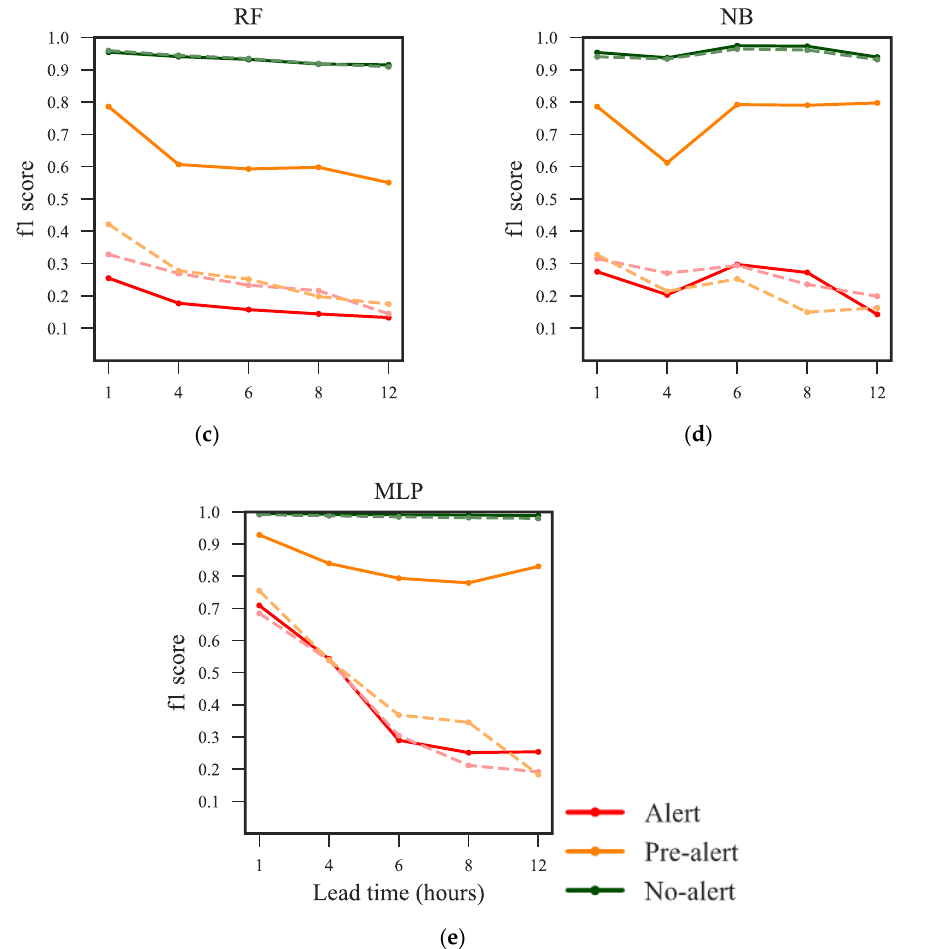
Figure 6. f1 scores per flood warning state ( No-alert , Pre-alert and Alert ) for all combinations of ML techniques across lead times. ( a ), Logistic Regression ( b ), K-Nearest Neighbors, ( c ) Random Forest, ( d ) Naïve Bayes, and ( e ) Multi-layer Perceptron. The brightest and dashed lines in each subfigure (color coding) represent the scores for the test